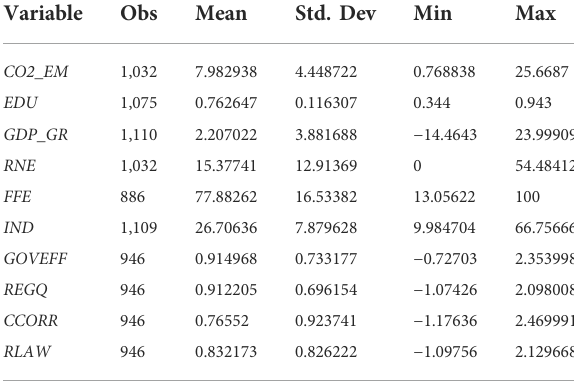
TABLE 2 Descriptive Statistics for the set of 43 members of G20 and